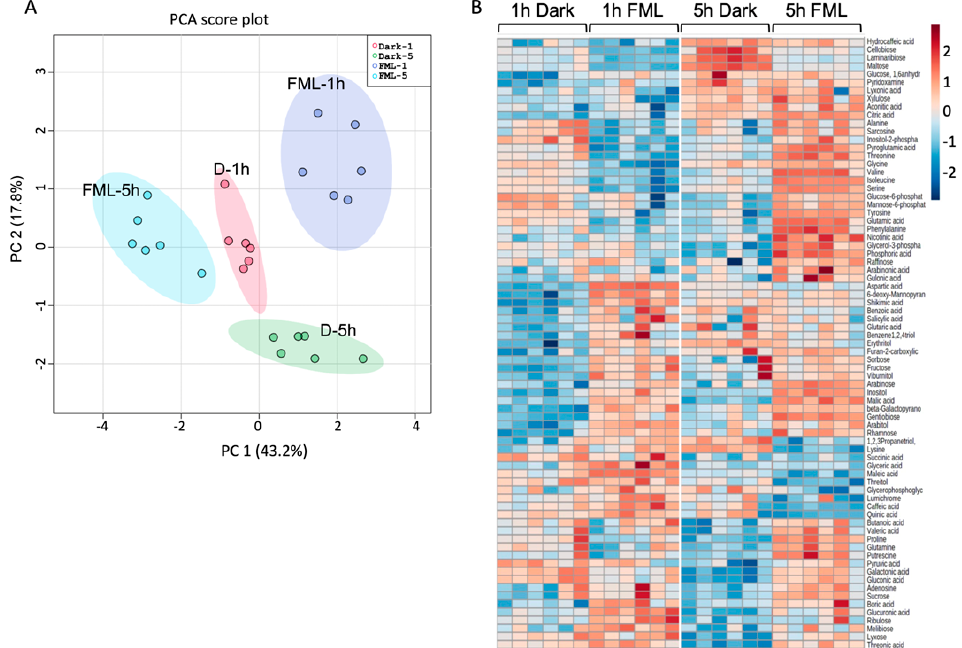
Figure 2. FML induces changes in primary metabolite profile of tobacco plants. ( A ) PCA score plot comparing metabolite profiles of tobacco leaves after exposure for 1 h and 5 h to darkness or FML. ( B ). Hierarchical clustering of differentially expressed metabolites. Each treatment is represented by six columns (six repeats).